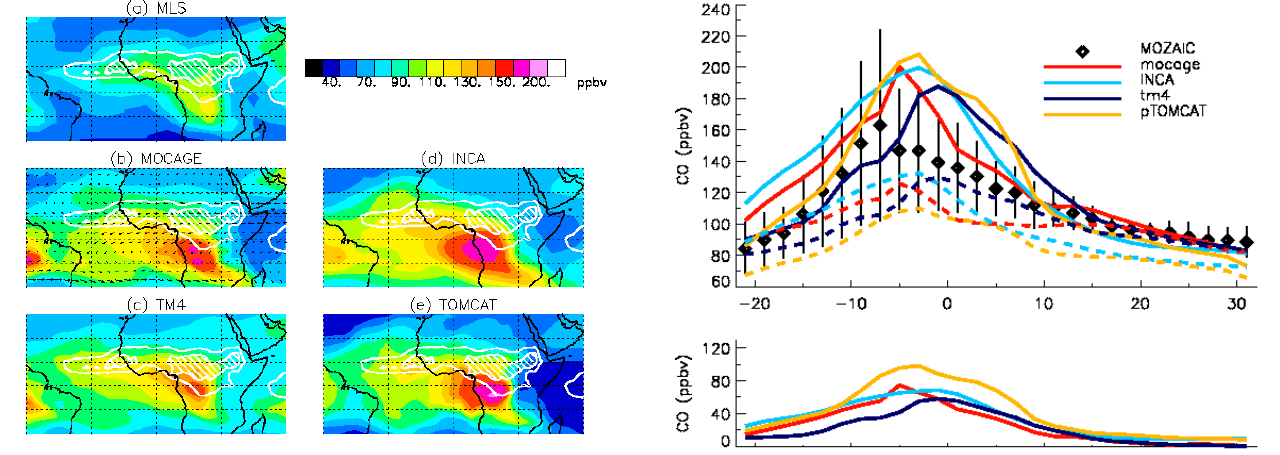
Fig. 3. August 2006 CO distribution at 215hPa (a) Aura/MLS ob- servations and simulations by (b) MOCAGE (c) TM4 (d) INCA and (e) p-TOMCAT. White contours indicate deep convection (OLR contours 240 and 215W/m 2 , with values below 215 hatched white).